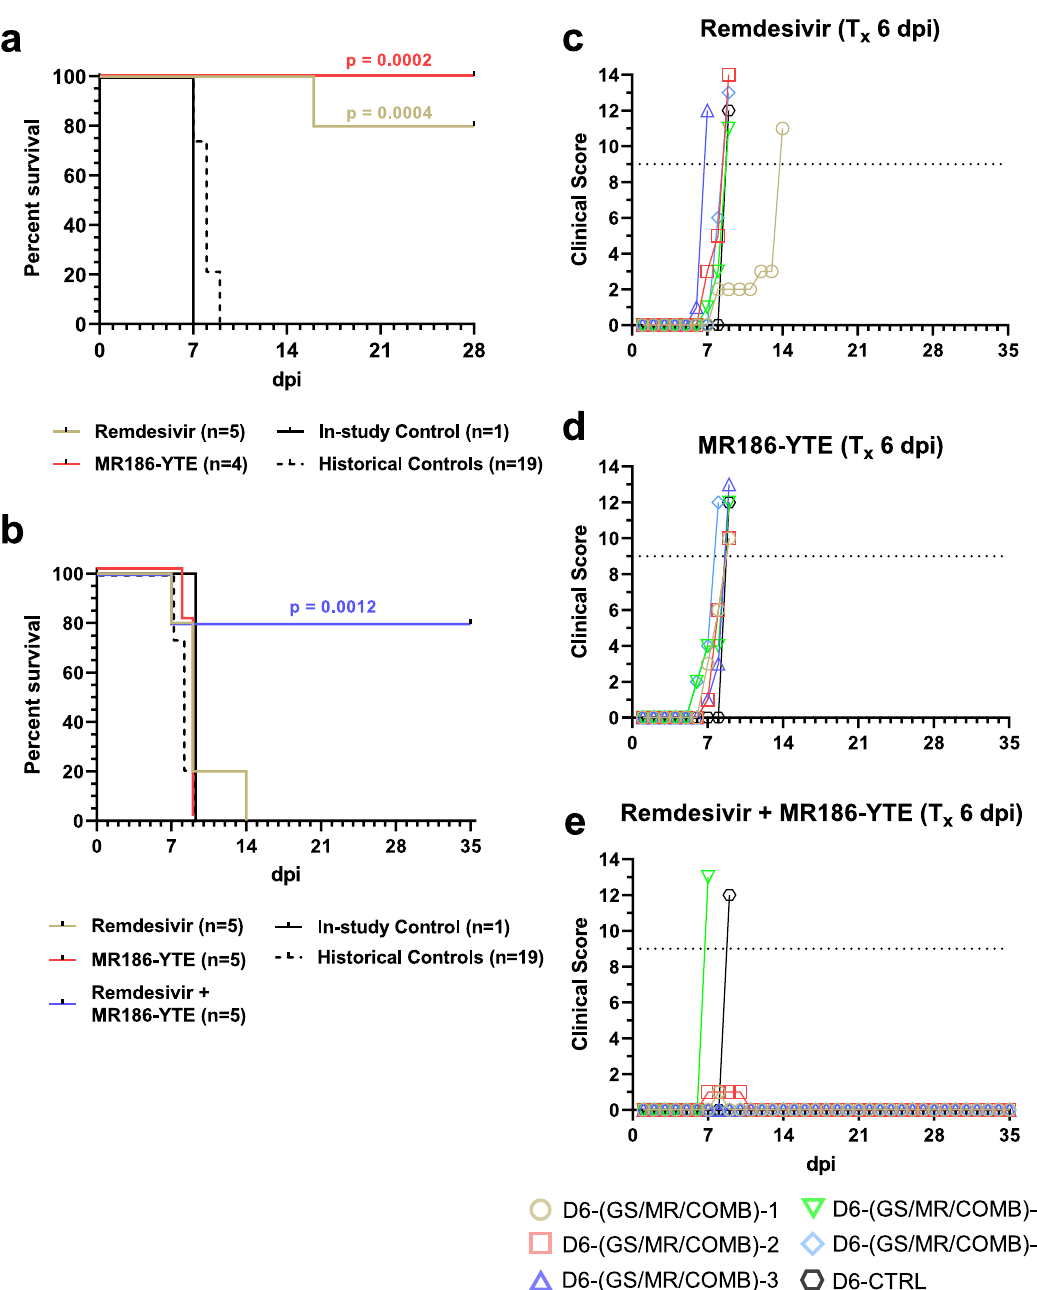
Fig. 1 Survival analysis and clinical scoring of rhesus macaques challenged with MARV virus. a Kaplan – Meier survival curves of rhesus macaques receiving treatment beginning 5 dpi and untreated and historical control animals. b Kaplan – Meier survival curves of rhesus macaques receiving treatment beginning 6 dpi and untreated and historical control animals. For ( a , b ), curves for the in-study control and historical control animals are shown separately; however, for statistical comparison, the in-study control was pooled with the historical controls. The reported two-tailed p value was derived from Fisher ’ s exact test corrected for multiple comparisons using the Hochberg method, and was rounded to four decimal places. c – e Clinical scoring for rhesus macaques with treatment initiated 6 dpi with remdesivir ( c ), MR186-YTE ( d ), and combined remdesivir/MR186-YTE ( e ). The horizontal dashed line represents the minimum clinical score by which euthanasia criteria was met. T x = “ treatment ” . Source data are provided as a Source Data fi